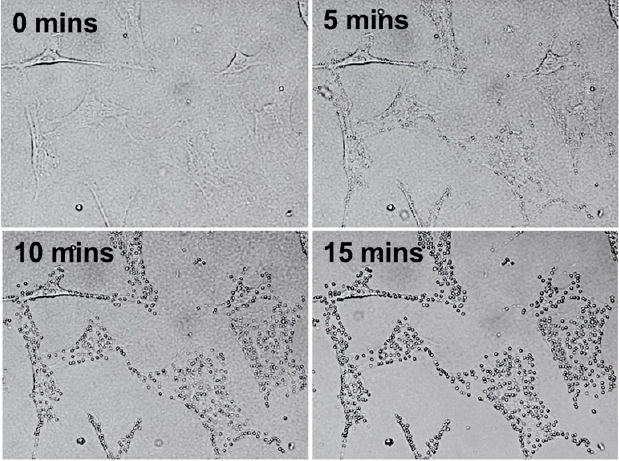
Figure 1. Optical microscope images of the effect of Era-50 on MC3T3-E1 cells after 0, 5, 10, and 15 min.